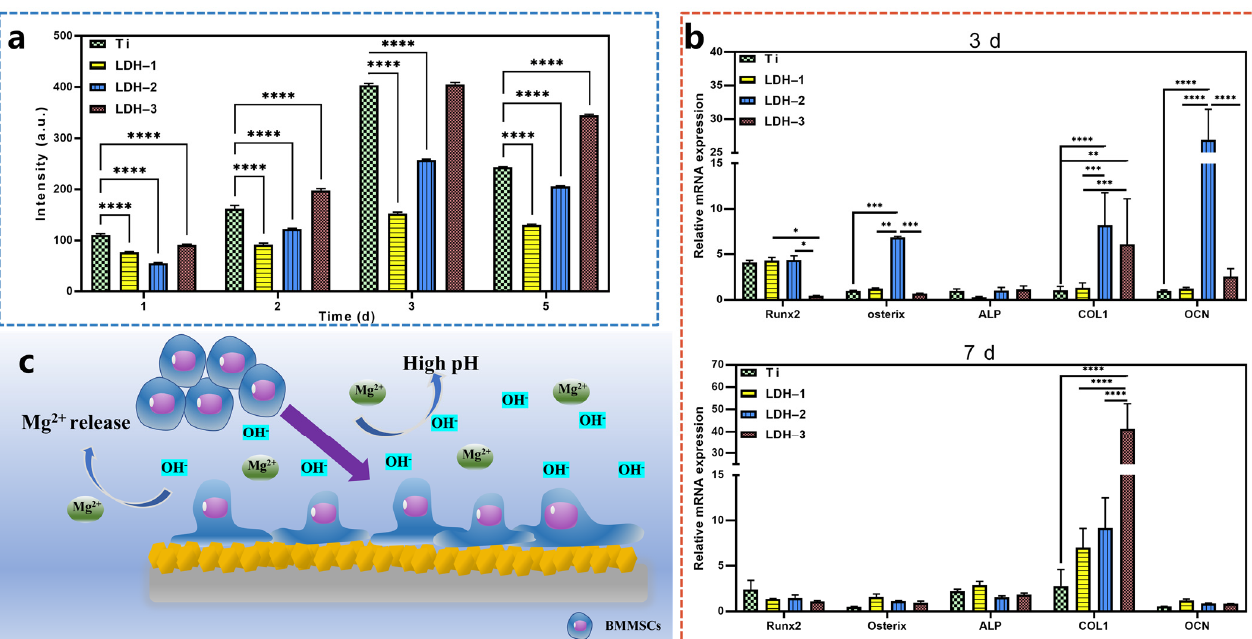
Figure 5. ( a ) BMMSCs proliferation activity on Ti, LDH − 1, LDH − 2, and LDH − 3 sample surfaces was detected by Alamar blue for 1, 2, 3, and 5 d; ( b ) expression of Runx2, Osterix, ALP, COL1, and OCN osteogenic genes of BMMSCs cultured on Ti, LDH − 1, LDH − 2, and LDH − 3 samples for 3 and 7 days; ( c ) schematic diagram of the osteogenic ability of the alkaline microenvironment containing Mg 2+ and OH − . (* p < 0.05, ** p < 0.01, *** p < 0.001, **** p < 0.0001)